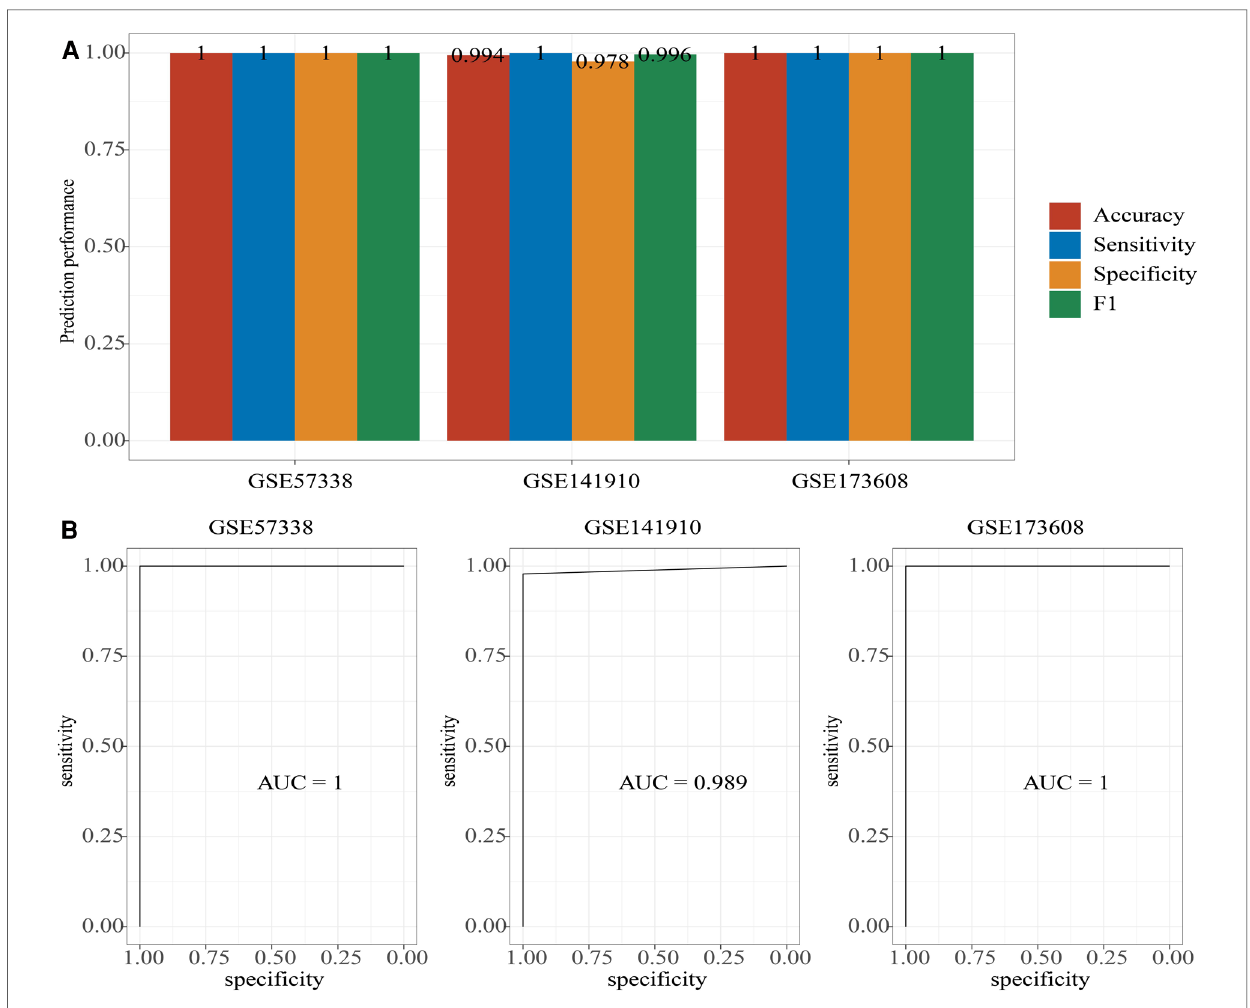
FIGURE 10 Construction of a diagnosis model. ( A ) The accuracy, sensitivity, speci fi city, and F1 of diagnosis model in GSE57338 dataset, GSE141910 dataset and GSE173608 dataset. ( B ) The AUC of diagnosis model in GSE57338 dataset, GSE141910 dataset and GSE173608